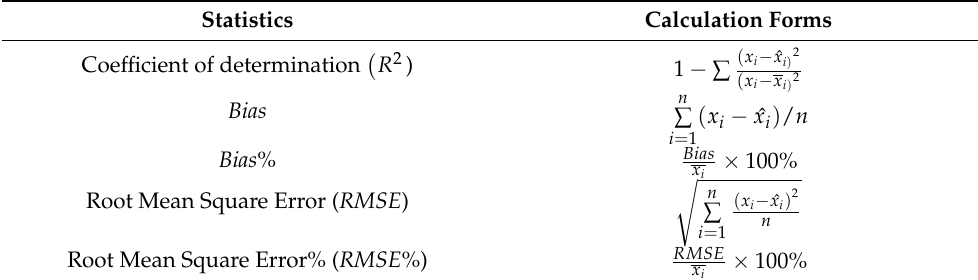
Table 5. Statistical accuracy of the BPLS, TLS, and field